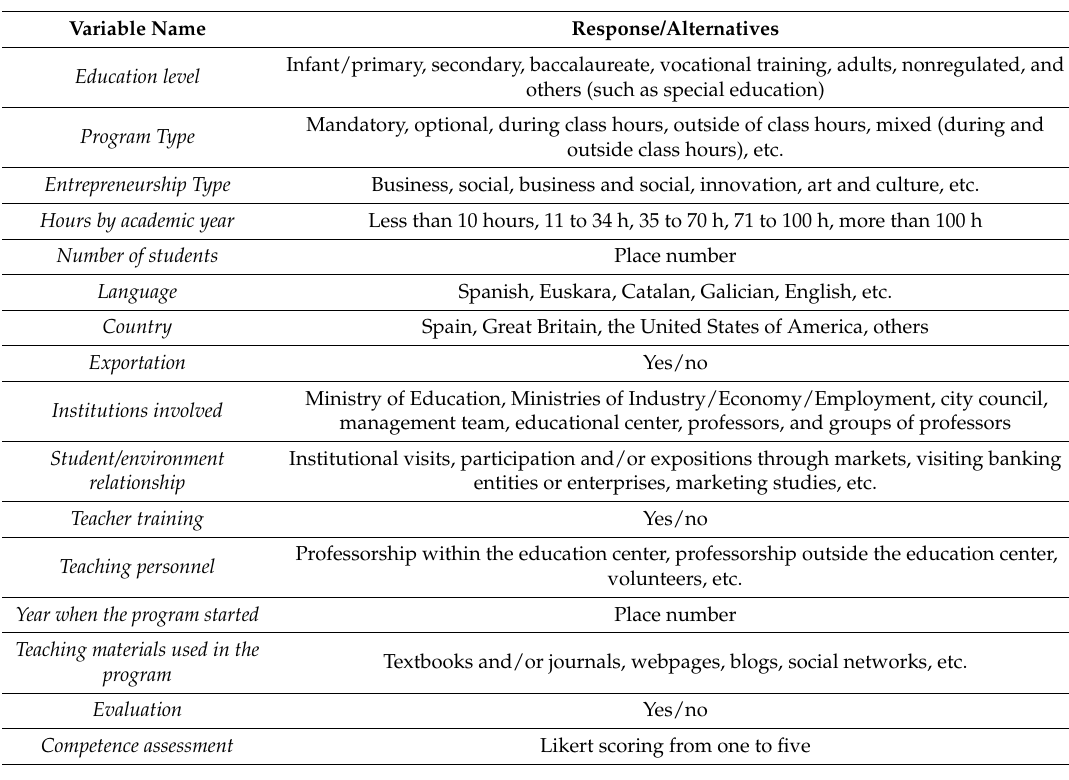
Table 2. Variables used in the